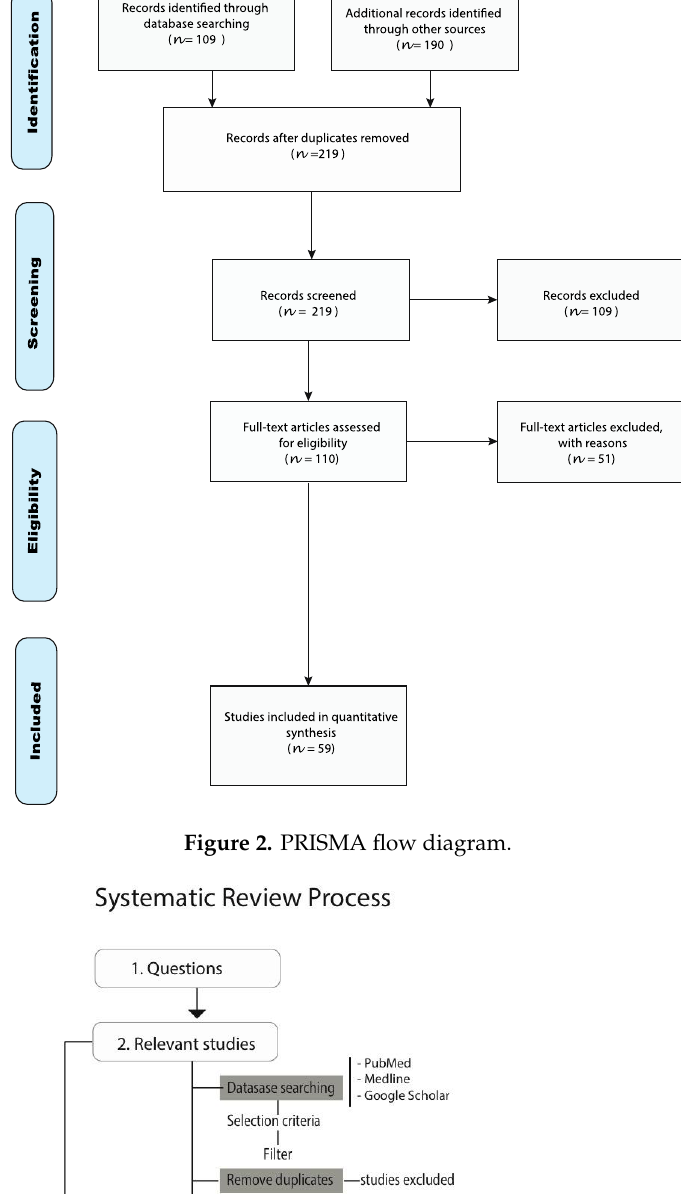
Figure 2. PRISMA flow diagram.